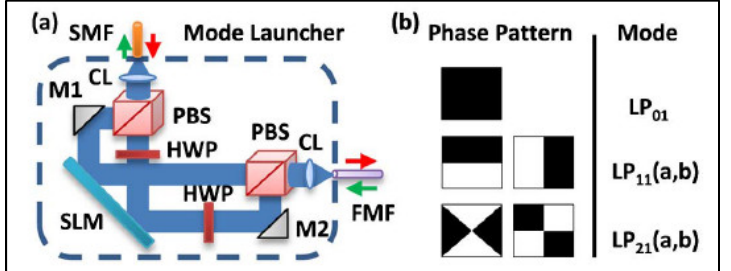
Figure 3. ( a ) Schematic diagram of a free-space mode launcher. ( b ) SLM phase patterns and the corresponding spatial modes. CL: collimating lens, M1/M2: turning mirror, HWP: half-wave plate, PBS: polarization beam splitter. (Reprinted/Adapted) with permission from [34] © The Optical So- ciety.